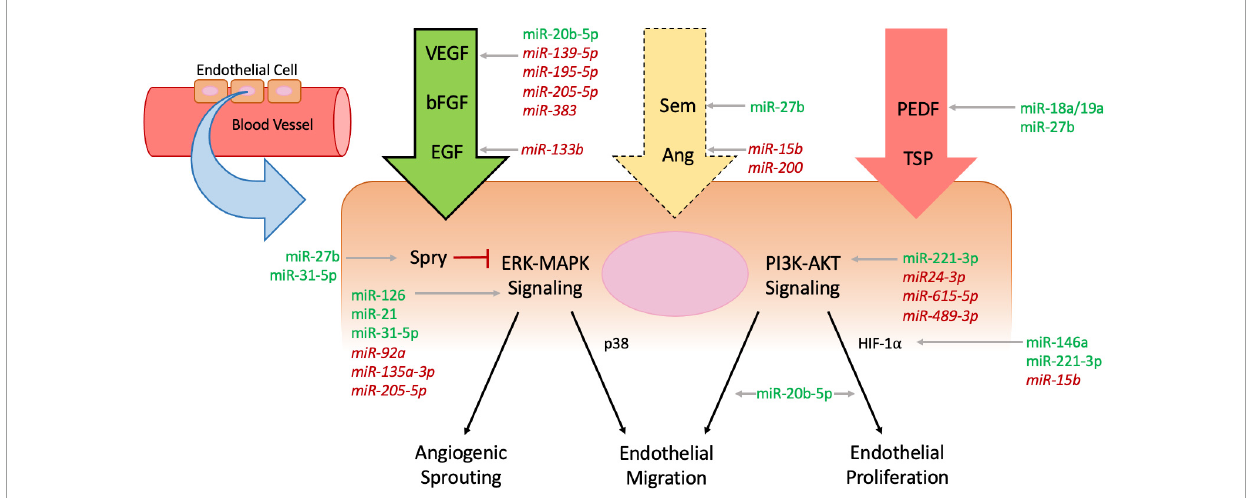
FIGURE1 Mechanisms of angiogenesis affected by microRNAs. Endothelial cells line blood vessel walls and are the main cells affected by processes of angiogenesis. Circulating pro-angiogenic factors (green arrow, bold outline), anti-angiogenic factors (red arrow, no outline), and mixed factors (yellow arrow, dashed outline) all interact with endothelial cells and influence intracellular signaling including the extracellular signal-regulated kinases-mitogen activated protein kinases (ERK-MAPK) and phosphatidylinositol 3-kinase (PI3K)-Protein Kinase B (AKT) pathways, which ultimately regulate angiogenic sprouting and endothelial migration and proliferation. Intracellular protein Sprouty (Spry) inhibits ERK-MAPK signaling to downregulate angiogenesis (red flathead arrow). MicroRNAs (MiRNAs) influence angiogenesis throughout the cellular pathways—pro-angiomiRs are denoted in green plain text and anti-angiomiRs in red italicized